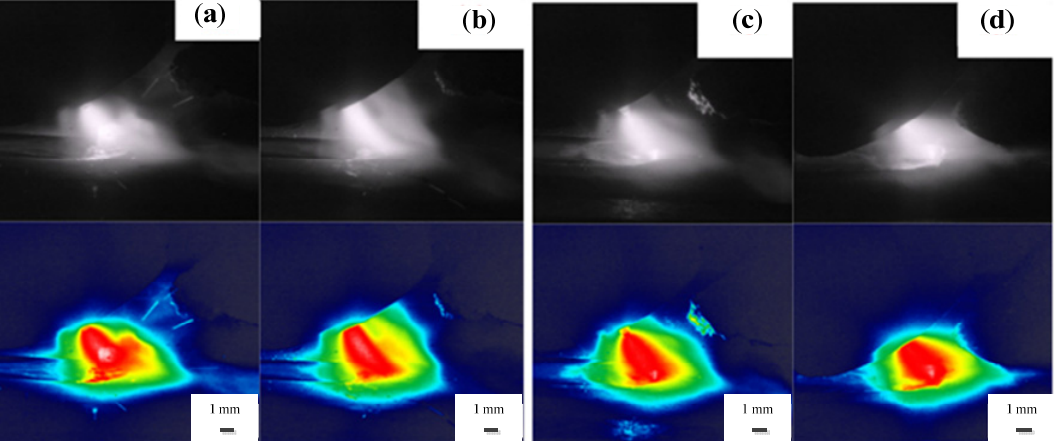
Figure 4. Schematic diagram of laser K-TIG hybrid arc profile at different K-TIG welding currents: ( a ) 220 A, ( b ) 260 A, ( c ) 300 A, ( d ) 340 A.